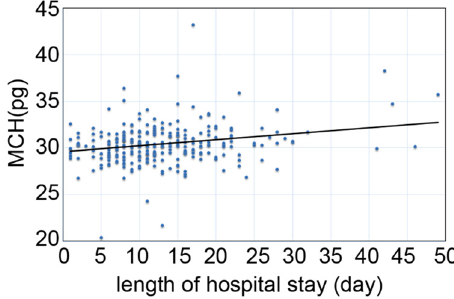
Figure 2: The correlation between length of hospital stay ( length of hospital stay ) and MCH of study participants ( n = 273 )